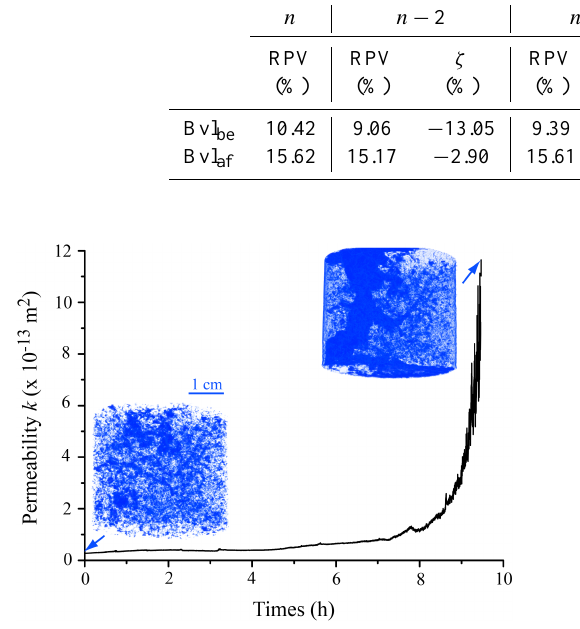
Figure 7. Time evolution of permeability k during dissolution ex- periment of sample Bvl. The corresponding 3-D images of the re- solved porosity for sample Bvl be and Bvl af are reported for the ini- tial and final percolation times.